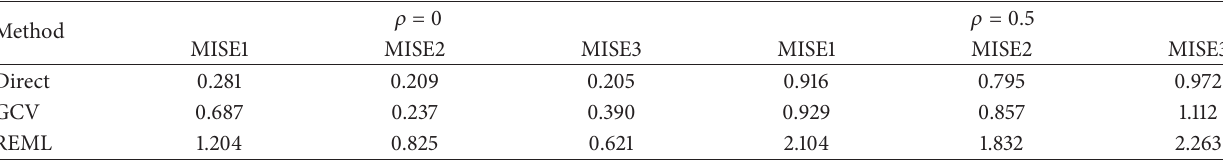
Table 4: Results of sample MISE of the penalized spline estimator. For each direct method, GCV and 𝜌 , MISE1, MISE2, and MISE3 are the ̂𝑓 ̂𝑓 ̂𝑓 sample MISE of 1 , 2 , and 3 , respectively. All entries for MISE are